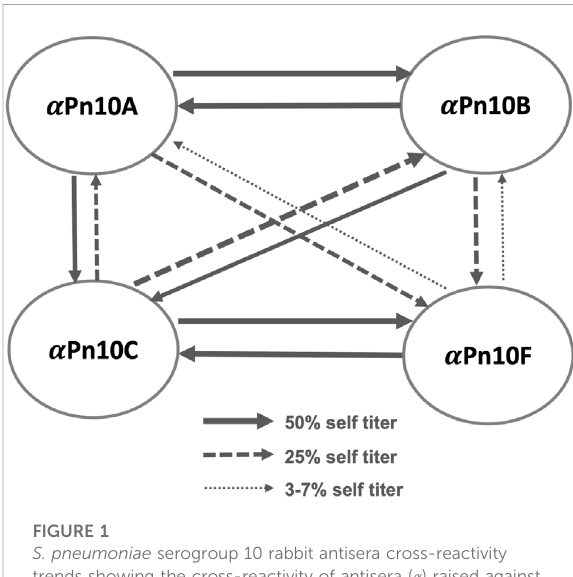
FIGURE 1 S. pneumoniae serogroup 10 rabbit antisera cross-reactivity trends showing the cross-reactivity of antisera ( α ) raised against serogroup 10 CPSs ( α Pn10A, α Pn10B, α Pn10C, and α Pn10F) (Henrichsen,1995).Self-cross-reactivity titerwassetas 100% with 50% self-titer, 25% self-titer, and 3% – 7% self-titer represented by solid arrows, dashed arrows, and dotted arrows,